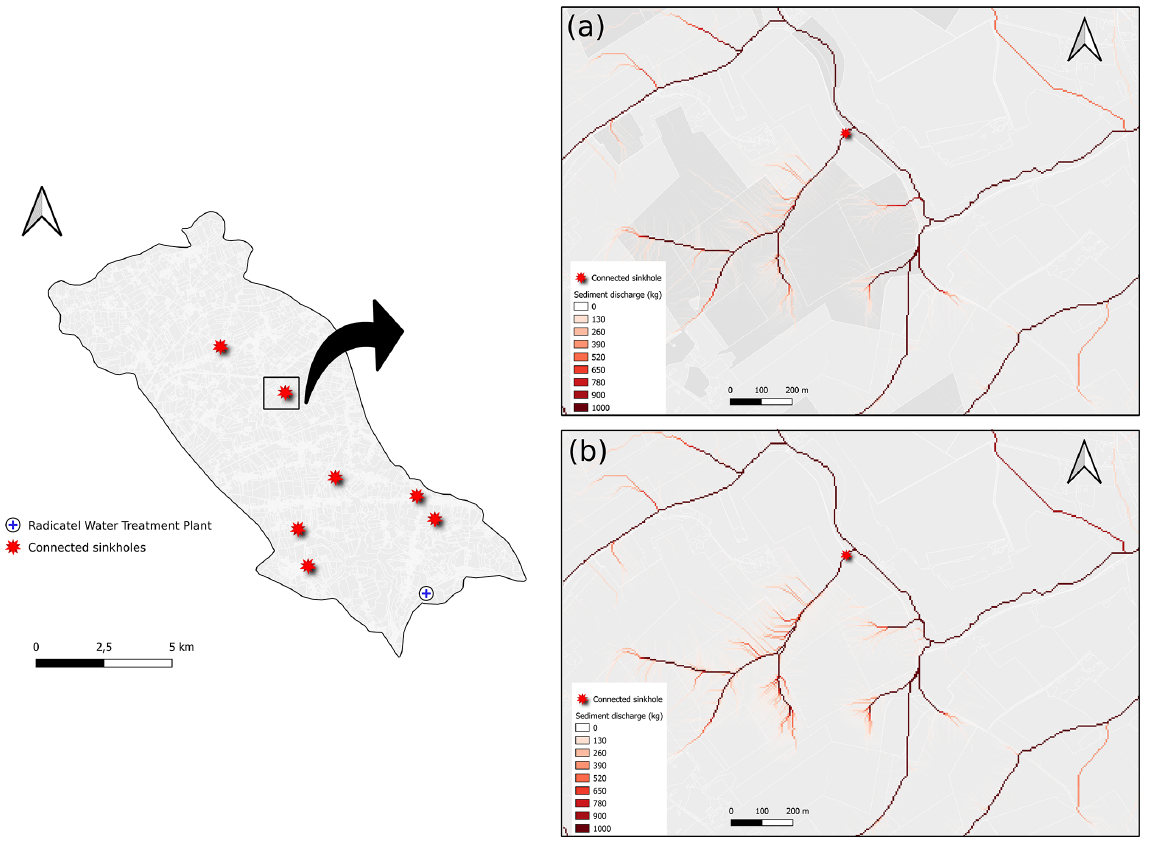
Figure 8. Mapping of flow path and sediment discharge for (a) the scenario including an increase of 15% of the infiltration capacity on selected plots (stronger grey colour) and (b) the baseline scenario, for the 10-year return period designed storm on the Radicatel catchment.